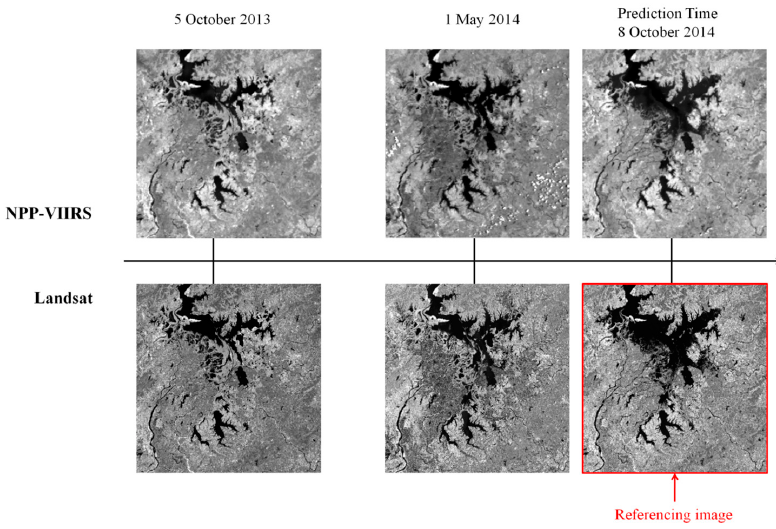
Figure 2. Three pairs of data sets from Landsat and NPP-VIIRS.